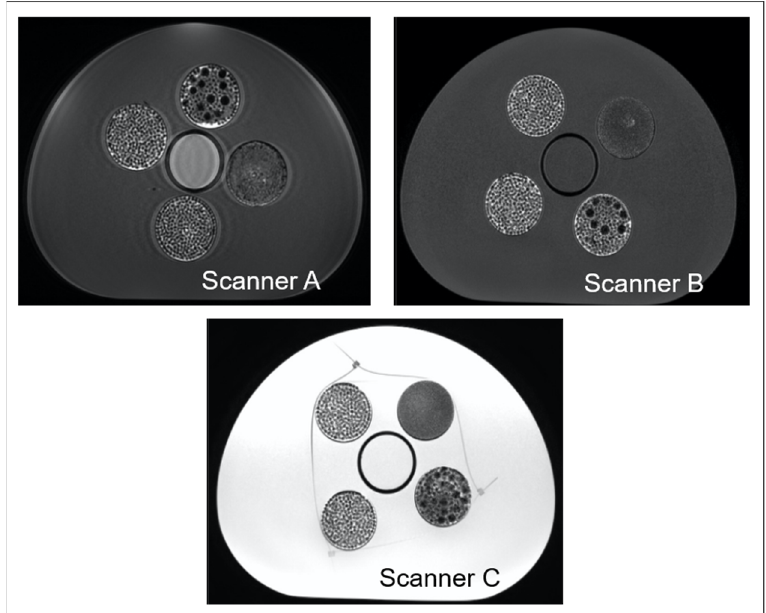
Figure 2. MR representation of the inserts embedded in the phantom on different scanners. On top left, the representation obtained on scanner A is shown. The representation obtained on scanner B is shown on top right, while the representation obtained on scanner C is shown at the bottom. NOTE: differences in background between scanner C and scanners A and B are due to the replacement of the aqueous solution of MnCl 2 by phantom oil (Spectrasyn 4 phantom oil; Philips Healthcare; T1 = 230 ms and T2 = 194 ms at 3T) to avoid dielectric artifacts intensified at higher field [9]. Window width/window level for the image of scanner A: 2175/1088; window width/window level for the image of scanner B: 43,380/22,690; window width/window level for the image of scanner C: 2208/1044.